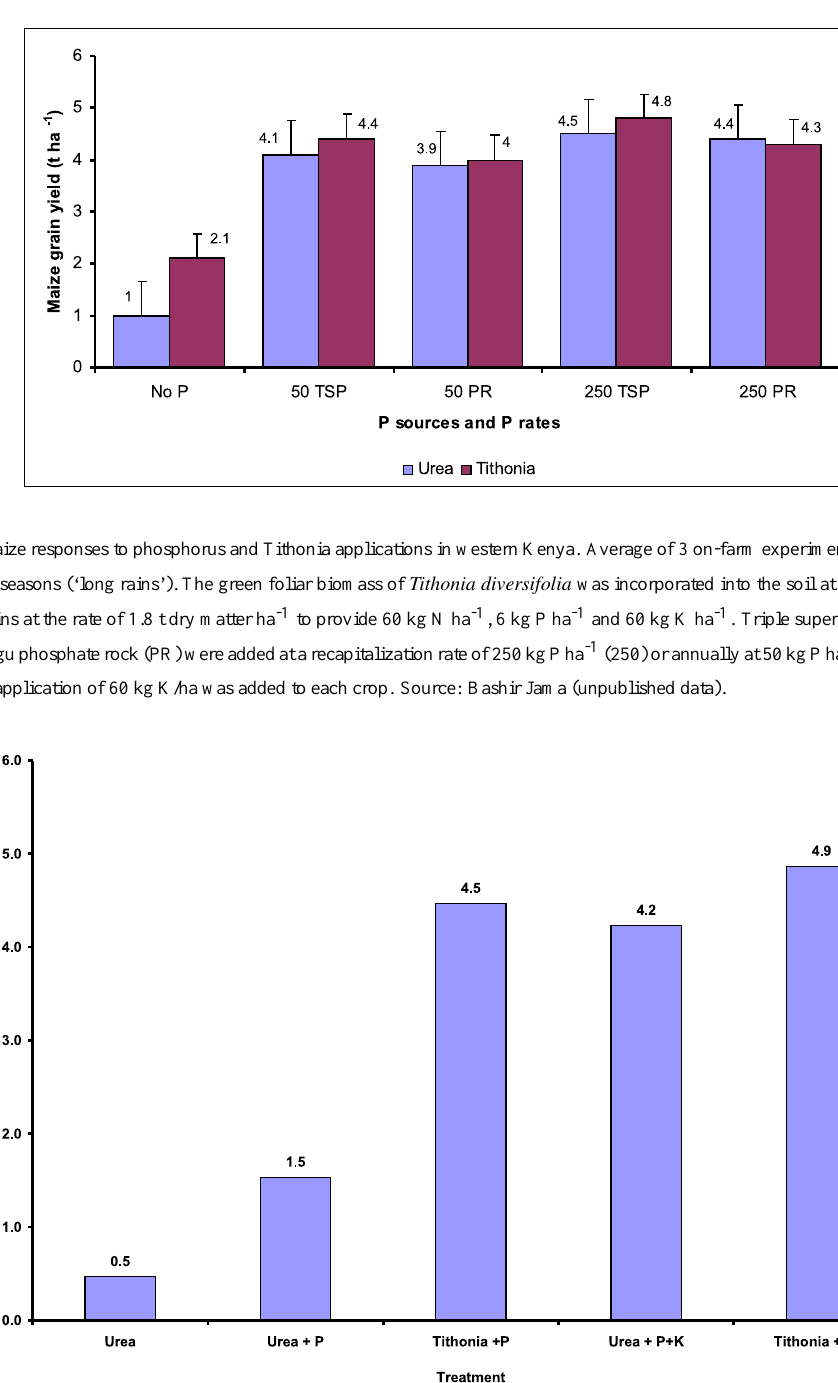
An Acad Bras Cienc (2006) 78